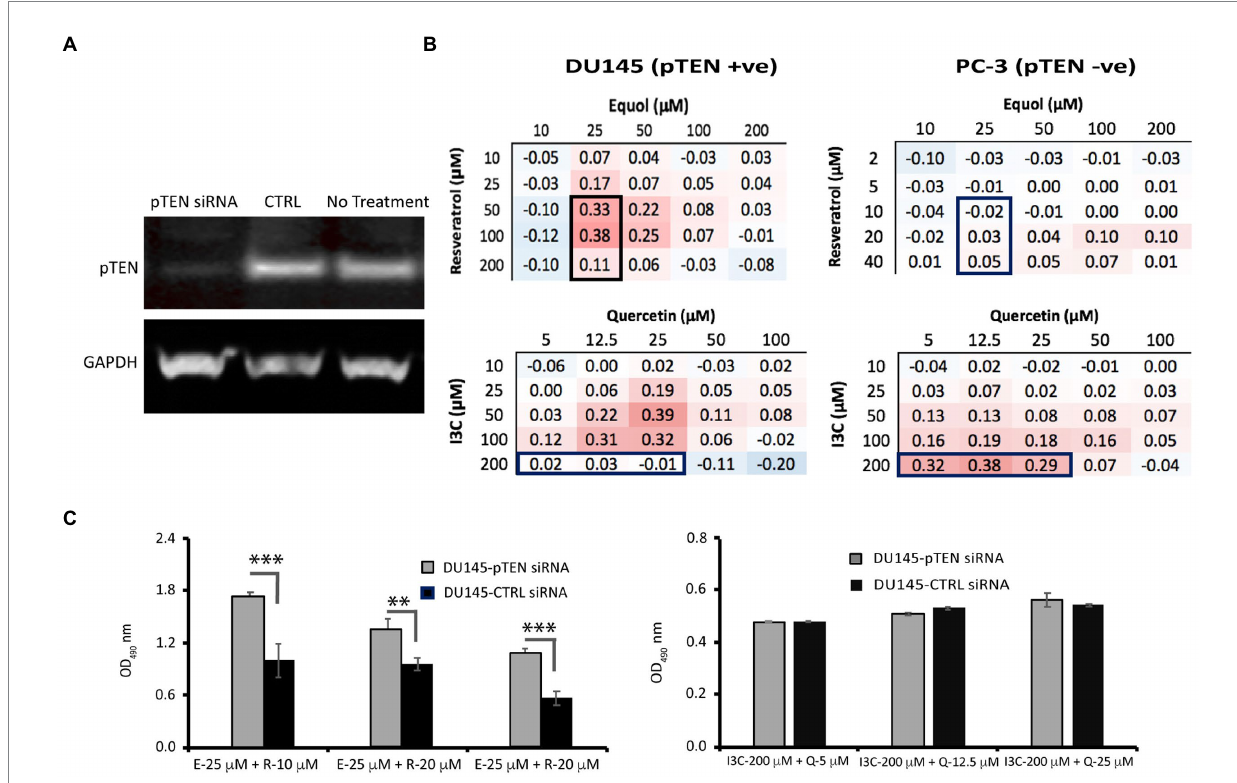
FIGURE 3 Effect of pTEN knockdown on resveratrol/equol synergy and I3C/quercetin synergy in DU145 cells. (A) DU145 cells were depleted of pTEN protein expression using siRNA knockdown as confirmed by Western blot analysis relative to the housekeeping protein glyceraldehyde phosphate dehydrogenase (GAPDH). (B) To test whether synergy in DU145 (pTEN +ve) cells was dependent on pTEN expression, three synergistic combinations of resveratrol/equol in DU145 cells but not in PC-3 (pTEN-null) cells (top panel boxed) and three combinations of I3C and quercetin that were not synergistic in DU145 cells but were in PC-3 cells (bottom panel boxed) were tested for their effect on cell viability by MTT assay in DU145 knockdown cells relative to wild-type DU145. (C) Cell viability post-pTEN-siRNA-mediated knockdown in DU145 cells 48 h. after transfection with pTEN siRNA (20 nM). Data are mean ± SD of triplicate determinations. *** p < 0.001; ** p < 0.01 versus control (unpaired Student’s t